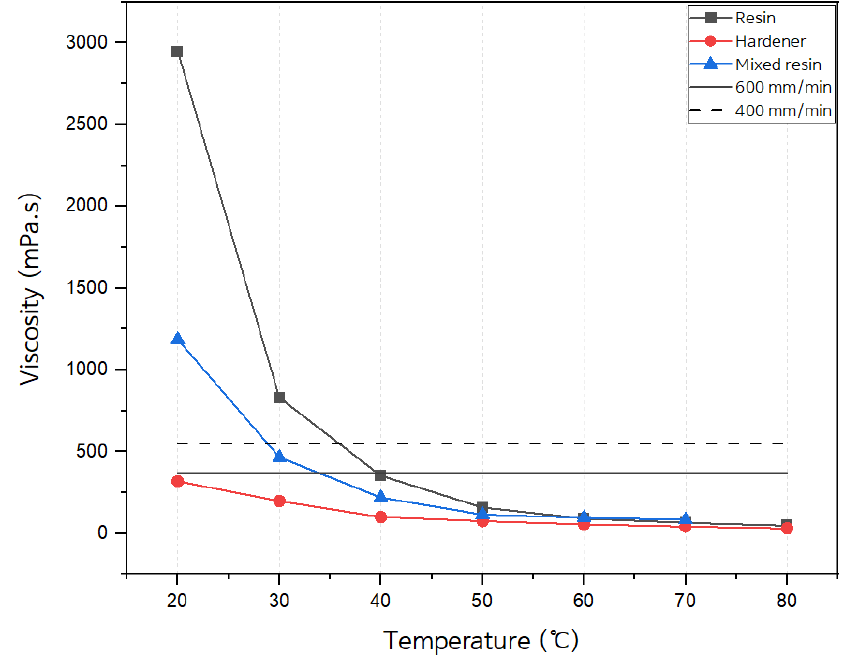
Figure 6. Resin viscosity at different temperatures and resin viscosity required at a specific pultru- sion speed.